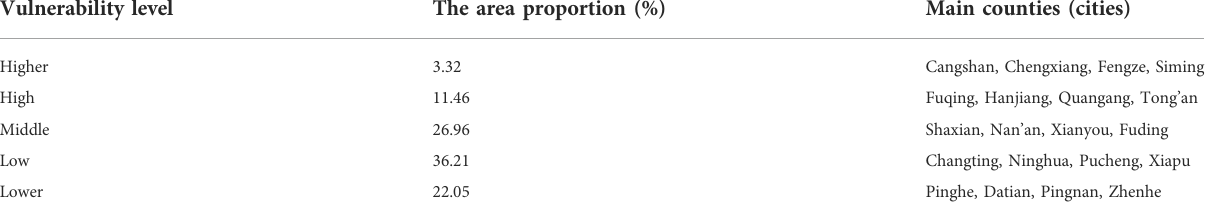
TABLE 5 Proportion of different vulnerability levels over the whole